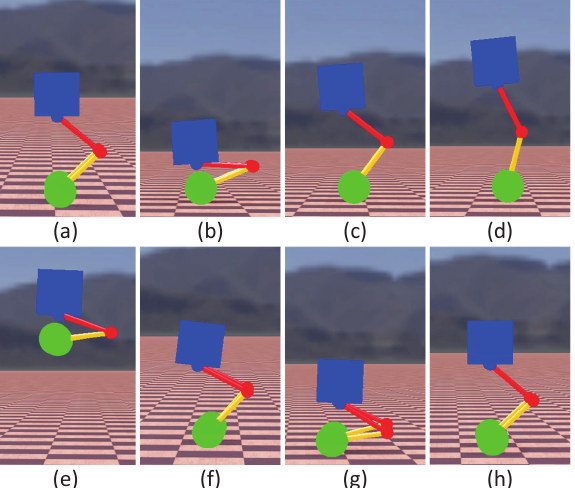
Figure 11. Snapshots of the simulation for the jumping. Photos ( a , b ) represent the squatting process of the robot. Photos ( c , d ) represent the take-off process of the robot. Photo ( e ) shows the state of the robot at the vertex. Photos ( f , g , h ) show the process of the robot landing.